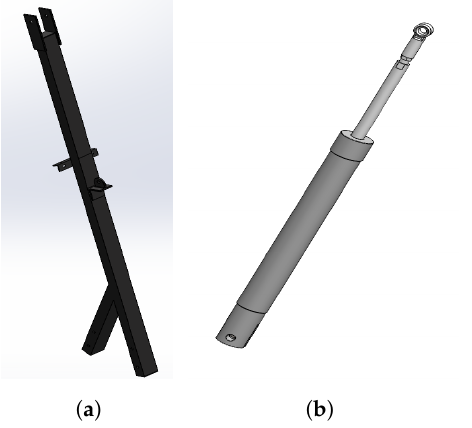
Figure 4. Mount apparatus; ( a ) base main rod and ( b ) hydraulic actuator. The upper frame consists of an upper support rod with load cells mounted on it and chains incorporated on both sides for U bar assembly. A strain load cell is used to measure the weight. It is used in z formation as a cantilever beam, mounted inside the front upper support rod and upper support rod. The components used for upper support and load cell used for weighing the patient are shown in Figure